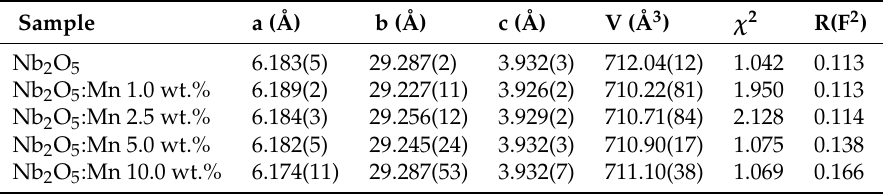
Figure 2. Rietveld refined XRD patterns of Nb 2 O 5 :Mn sample ( a ) 1.0 wt.%, ( b ) 10.0 wt.%, annealed at 700 ◦ C. Table 1. Structural parameters obtained from the Rietveld refinement of the XRD